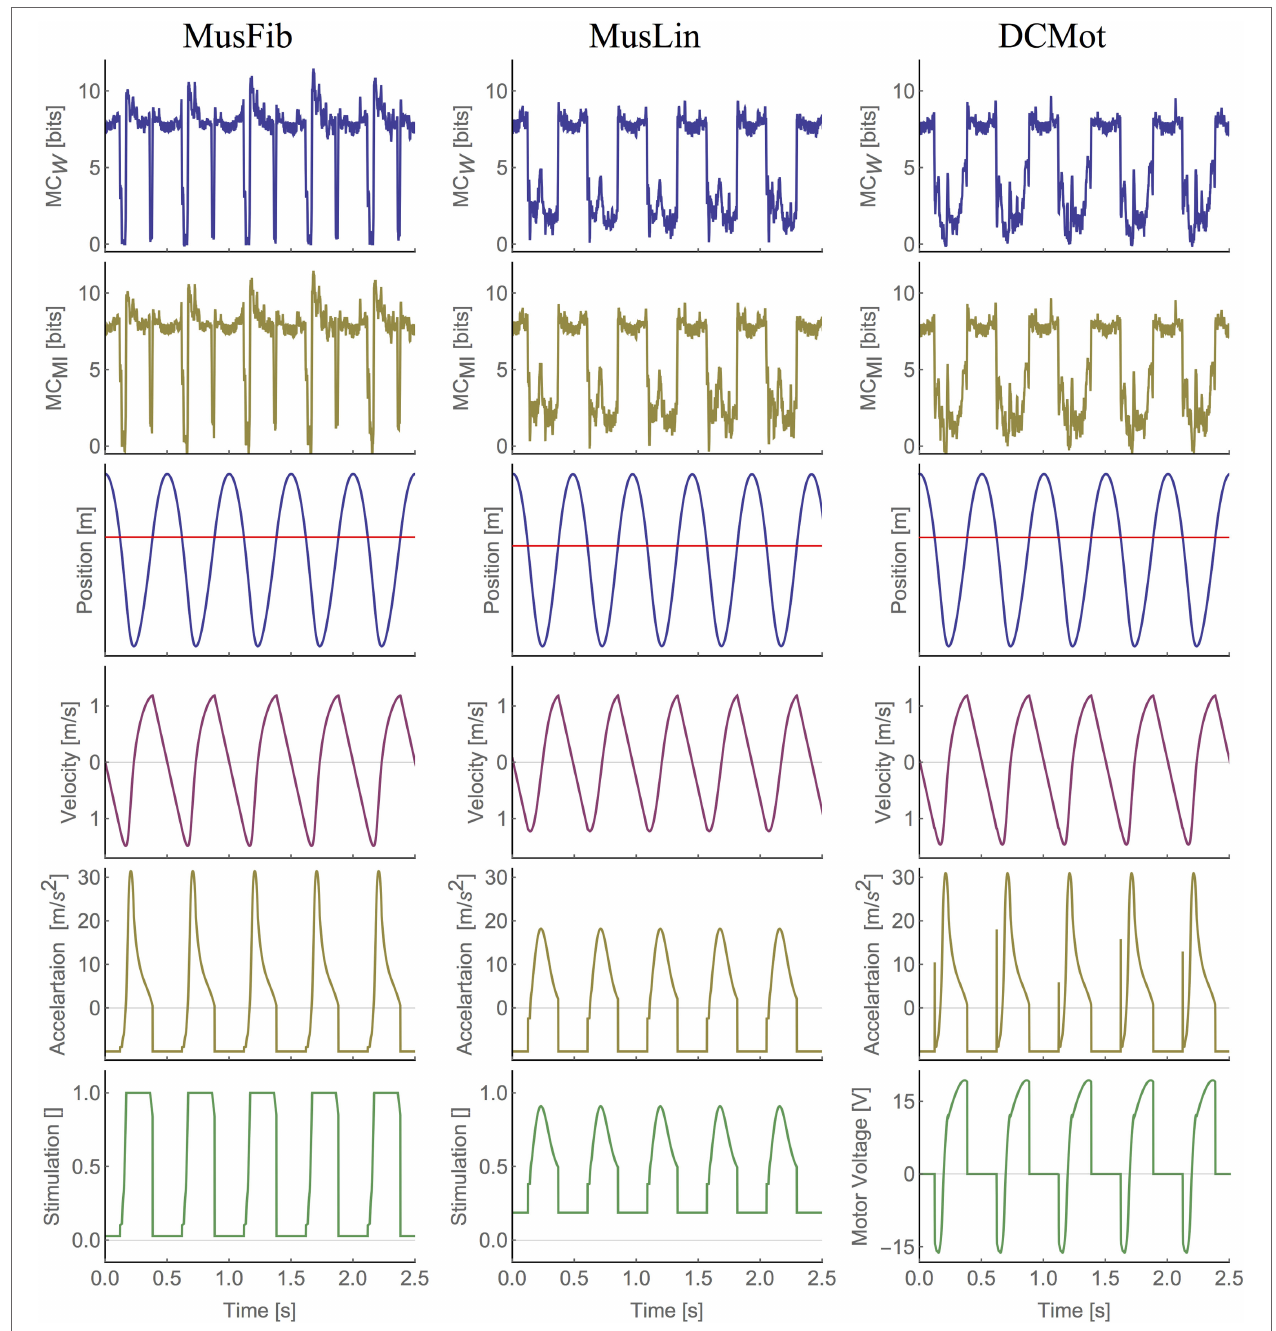
FIGURE 4 | Plots of state-dependent MC (first two rows) and the world state (following four rows) for all muscle models . The red line in the position plot indicates the time steps at which the hopper touches ground (position is below the red line). Note that the stimulation is dimensionless.